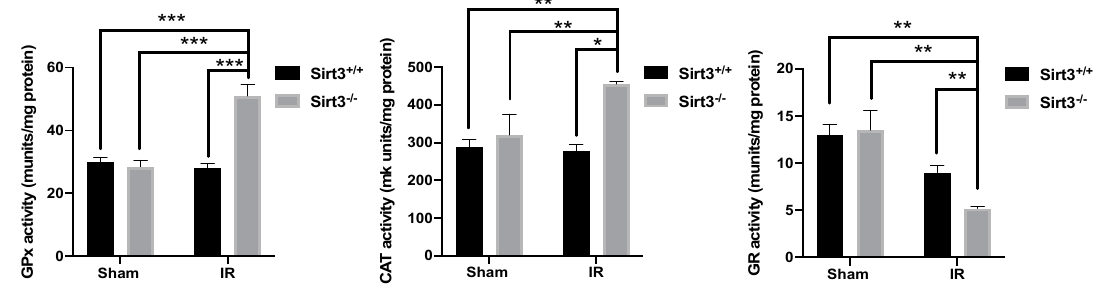
Figure 9. Glutathione Peroxidase (GPx) and catalase (CAT) activity were significantly increased while Glutathione Reductase (GR) enzymatic activity was decreased in irradiated Sirt3 − / − mice compared to sham irradiated Sirt3 +/+ or Sirt3 − / − as well as Sirt3 +/+ irradiated groups ( n = 4–6; * p < 0.05, ** p < 0.01, *** p < 0.001).